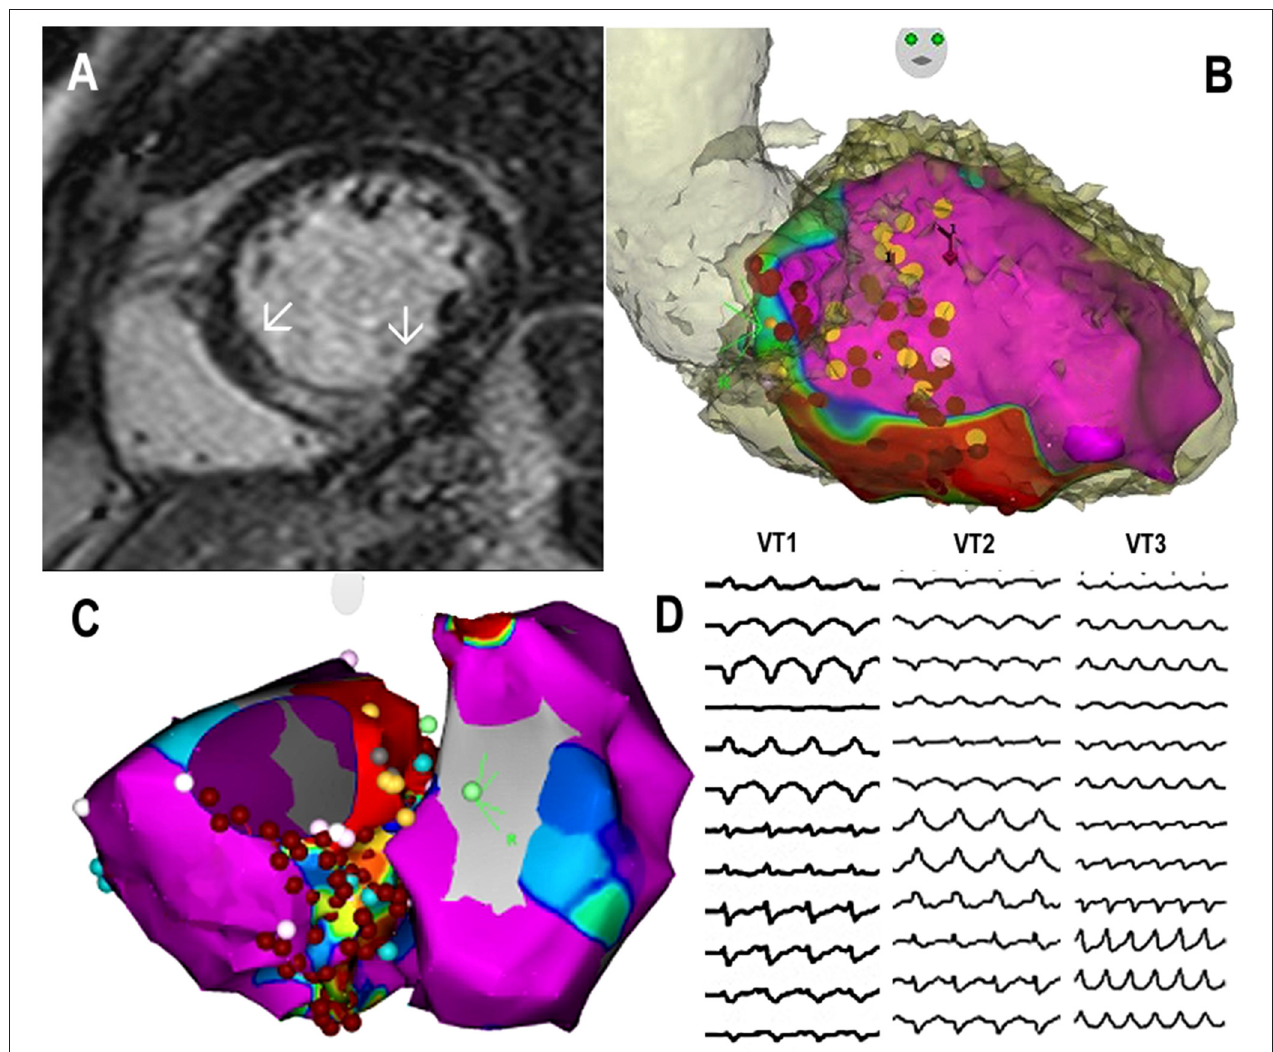
FIGURE 3 | Clinical findings from Case 3: (A) MRI with late gadolinium enhancement within the basal septum and adjacent inferior wall (arrows); (B) electroanatomical bipolar voltage map merged with CT angiogram of the left ventricle in right anterior oblique (RAO) view, displaying low voltage inferoseptally and ablation points in this region and at midseptal level before 1st stereotactic body radiotherapy (SBRT); (C) electroanatomical bipolar voltage maps obtained during third catheter ablation before 2nd SBRT, showing a larger area of low voltage in the entire basal septum up to outflow tract with ablation points; (D) ECG recordings of dominant ventricular tachycardia (VT) morphologies: VT1 and VT2 before the first SBRT, VT3 before the second SBRT. Note change in the exit from the low septum to high septum for